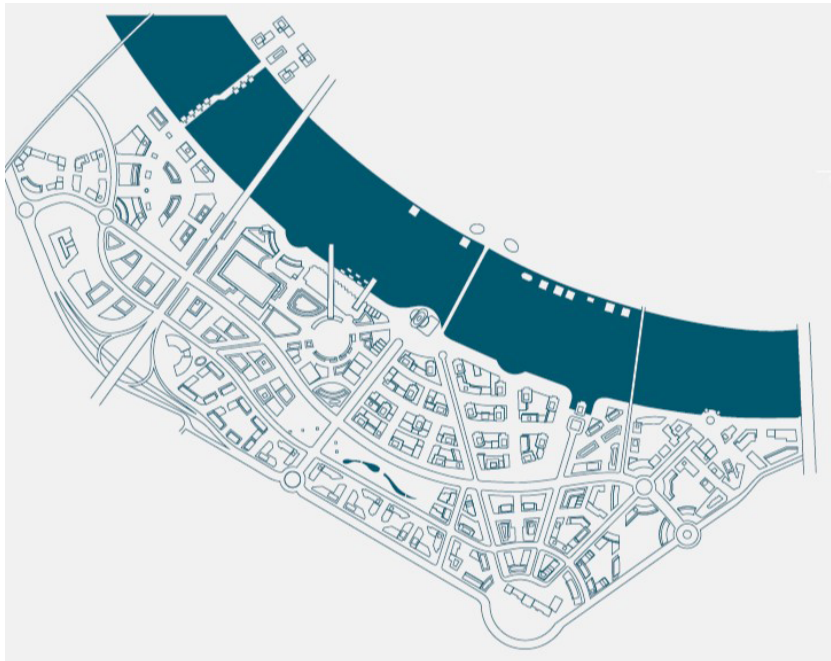
Figure 3. The ‘instant design’ of Belgrade Waterfront as presented within the original brochure. Source: Eagle Hills